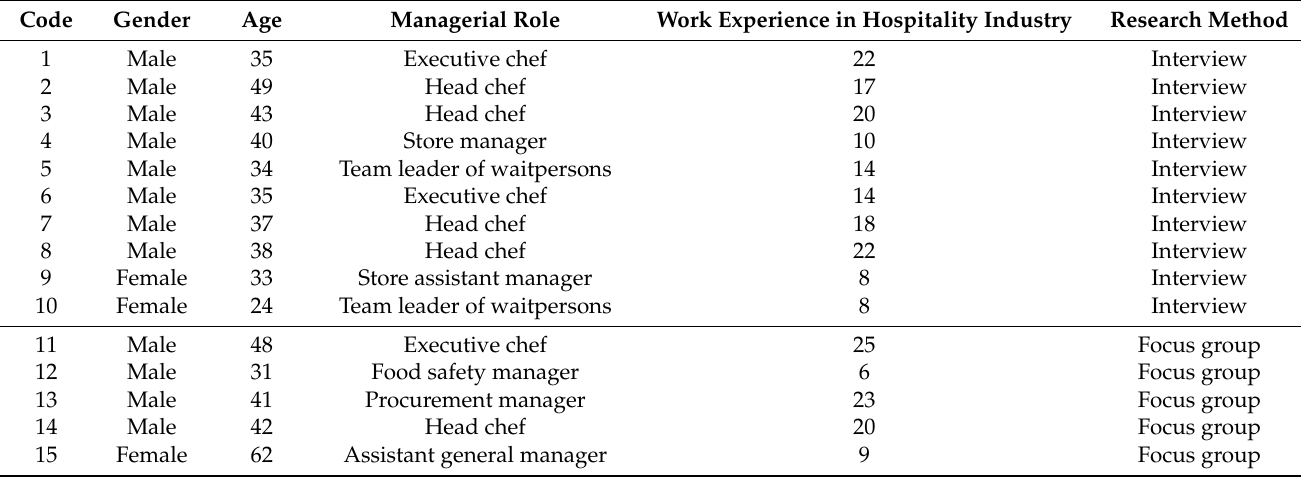
Table 1. Demographic information of